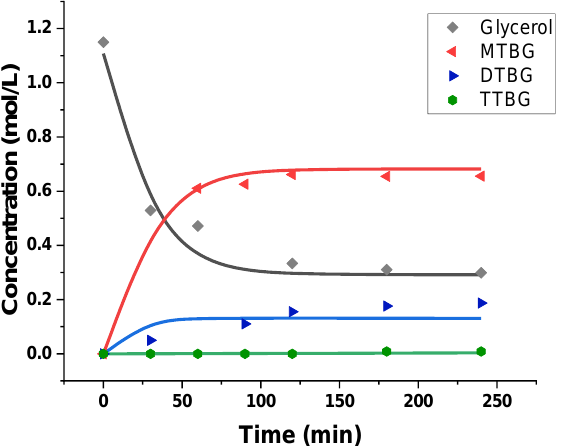
Figure 5. Experimental molar concentrations (symbols) and kinetic simulations (lines) as a function of time at 363 K and a reaction time of 8 h.